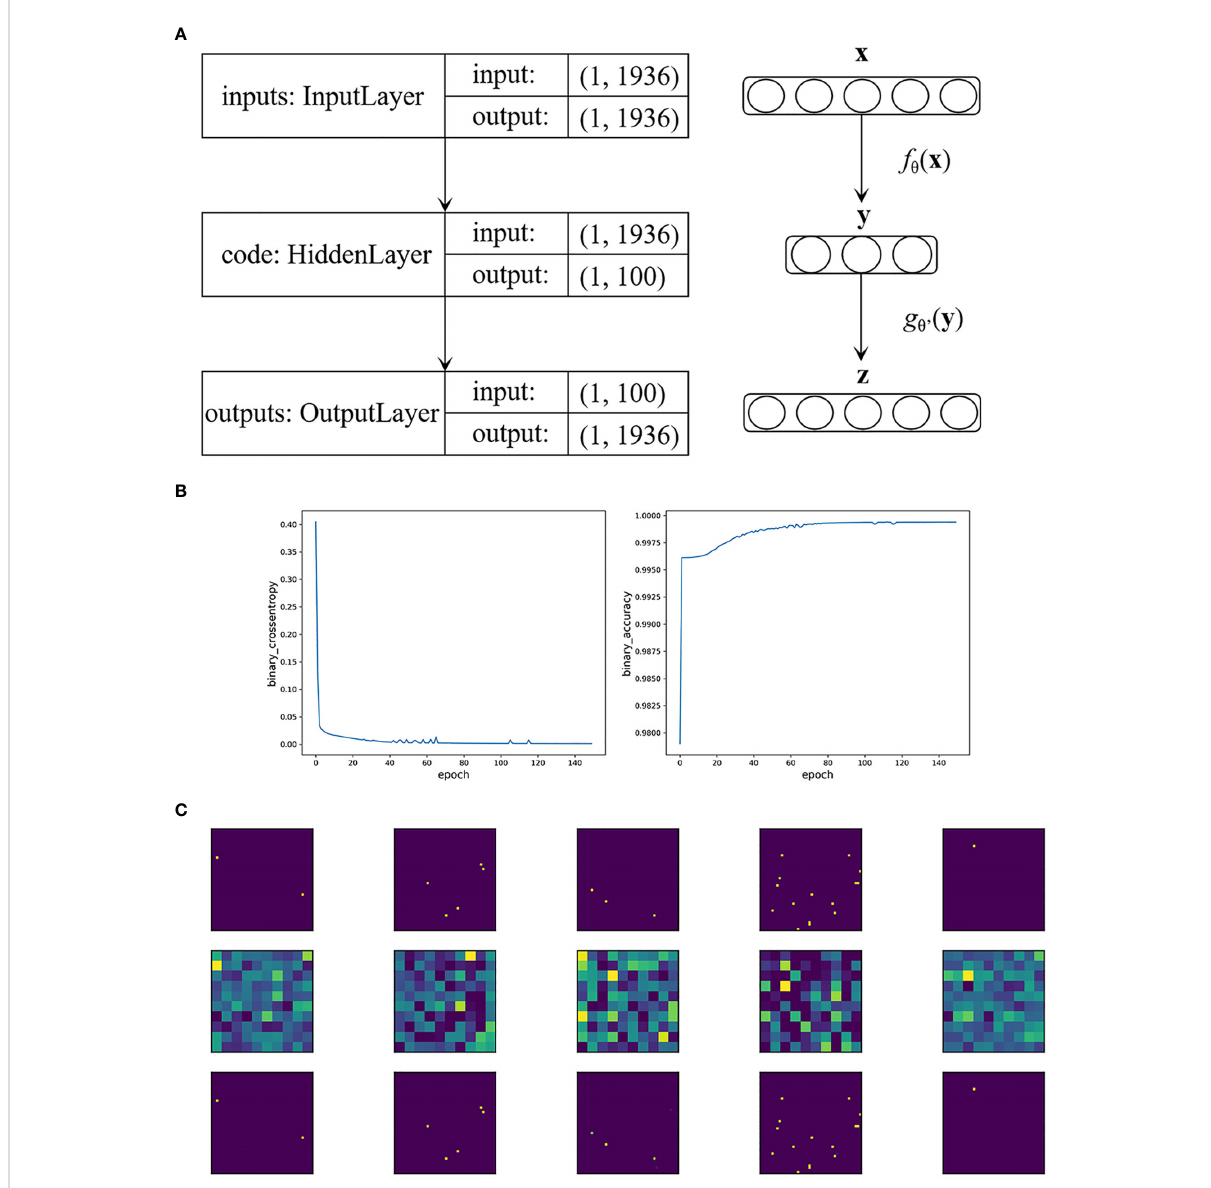
FIGURE 1 (A) The construction of the auto-encoder in BRCA data. (B) Loss function value and accuracy of the auto-encoder in BRCA data by the epoch times. (C) The fi rst fi ve visualized genetic signal of BRCA data. The fi rst row shows the original images, the second row shows the extracted features, and the third row shows that the images were restored accurately with the extracted